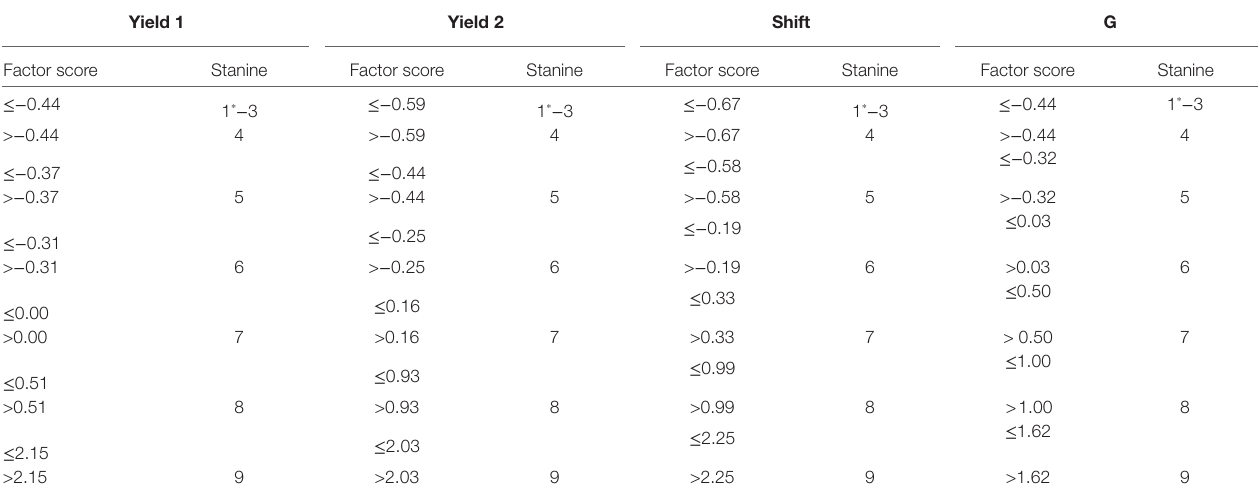
TABLE 5 | Factor scores norm for Yield 1, Yield 2, Shift, and G ( N = 560).